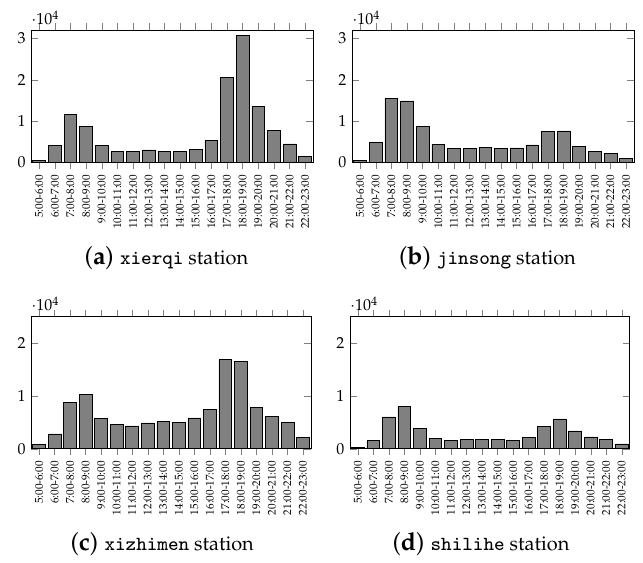
Figure 3. Traveler volume over equivalent time (hourly) of entering